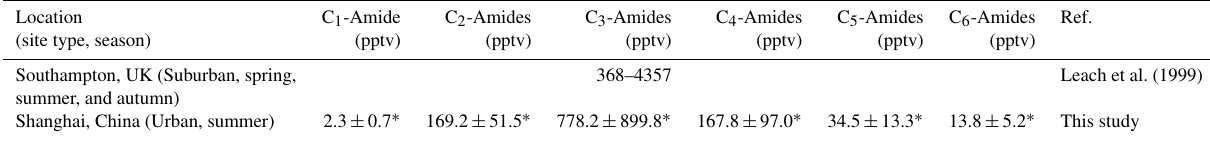
Table 3. Inter-comparison of gaseous amides measured in different locations with different surroundings. Location